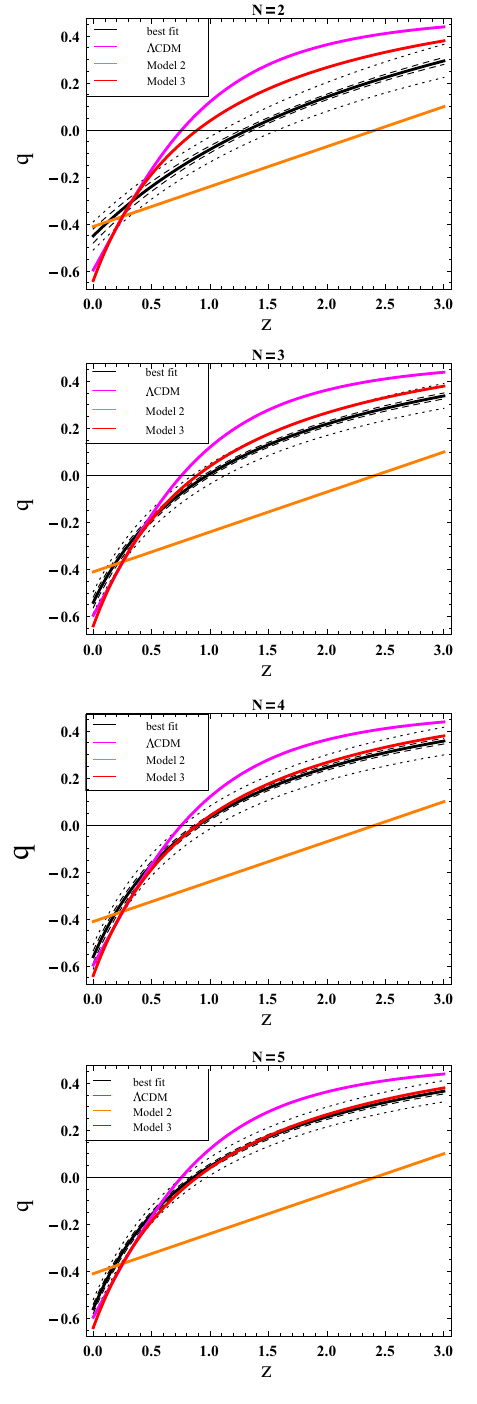
Fig. 2 The deceleration parameter q ( z ) is reconstructed for the parametrization given by Eq. (23) using different values of N , as indi- cated in the each panel . The central thick line ( black ) represents the best-fit curve, while the dashed and dotted contours represent the 1 σ and2 σ confidencelevel,respectively.Ineachpanel,the orange , red and magenta lines represent the trajectory of q for Models 2 and 3 and the (cid:5) CDM model (with (cid:6) (cid:5) = 0 . 73), respectively. Also, the horizontal 0 thin line indicates q ( z ) = 0